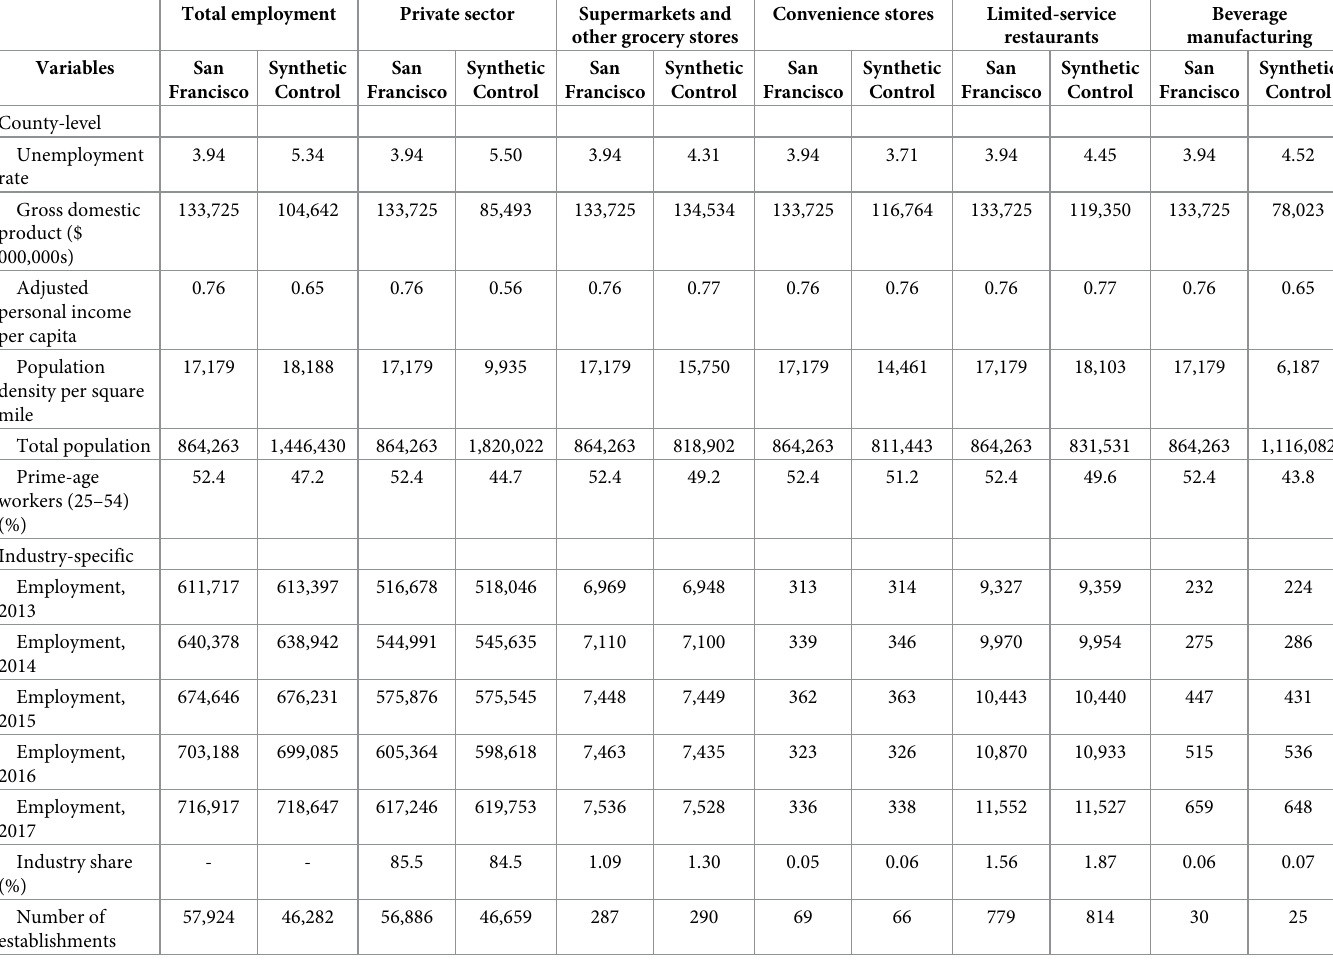
Table 2. Predictor balance for San Francisco and its synthetic control for total, private sector, supermarket and other grocery store, convenience store, limited-ser- vice restaurant, and beverage manufacturing